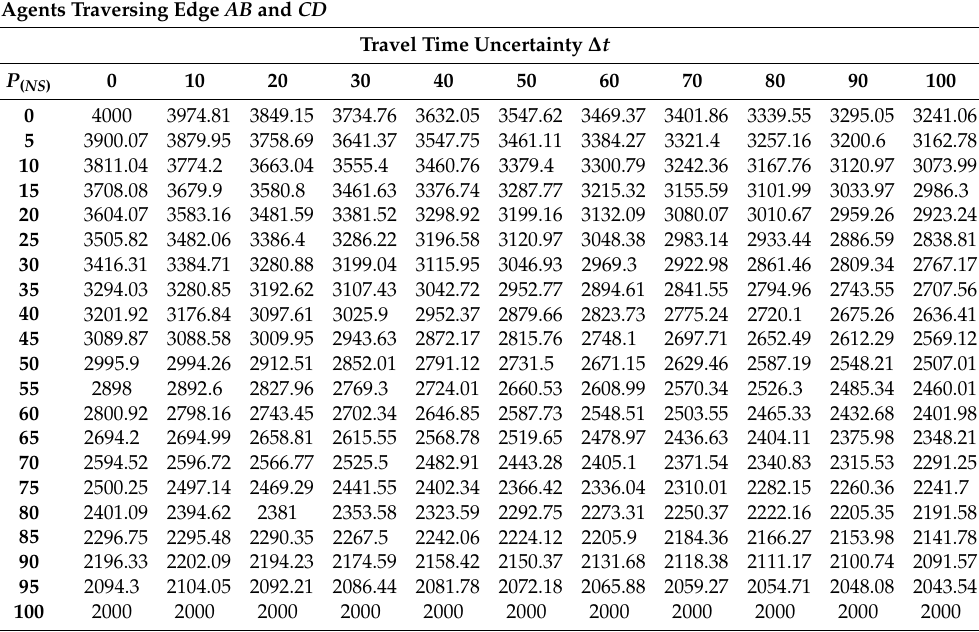
Table A1. Average number of agents traversing edge AB and CD for given values of ∆ t and P ( NS ) . Agents Traversing Edge AB and